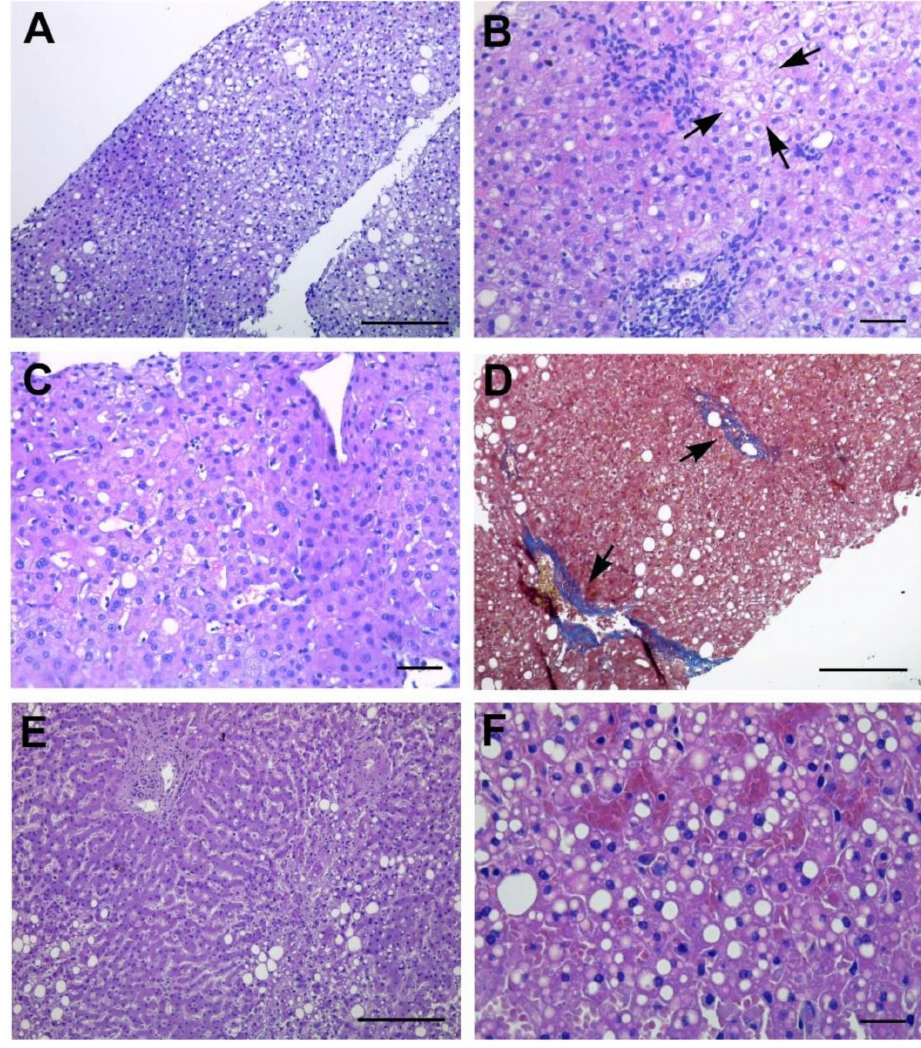
Figure 1. Histopathological features of liver biopsies and autoptic liver. ( A – D ) Liver biopsies show macrovesicular steatosis ( A ), and mild portal and lobular inflammation with spotty necrosis with presence of ballooning degeneration (arrows) ( B ). Sinusoidal dilatation in centrilobular areas is visible ( C ). Masson’s trichrome stain highlights mild fibrous expansion (arrows) ( D ). ( E , F ) Autoptic liver sections show macrovacuolar steatosis, and dilated but intact sinusoidal architecture; vascular fibrosis and spotty necrosis are visible ( E ). Hepatic sinusoidal dilatation and extravasation of red blood cells into the Disse’s space are visible; extensive steatosis is evident ( F ). Scale bars: A , D , E = 50 µ m; B , C = 14 µ m; F = 7 µ